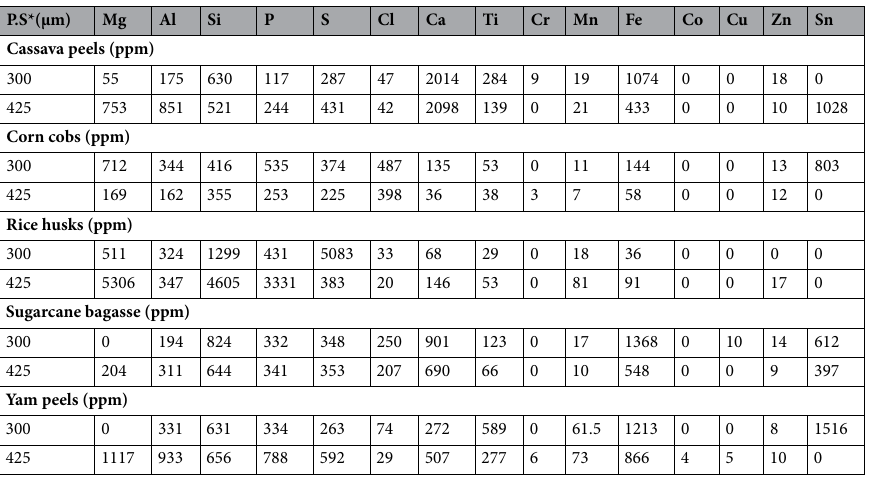
Table 3. Effects of particle size. P.S* — Particle size.